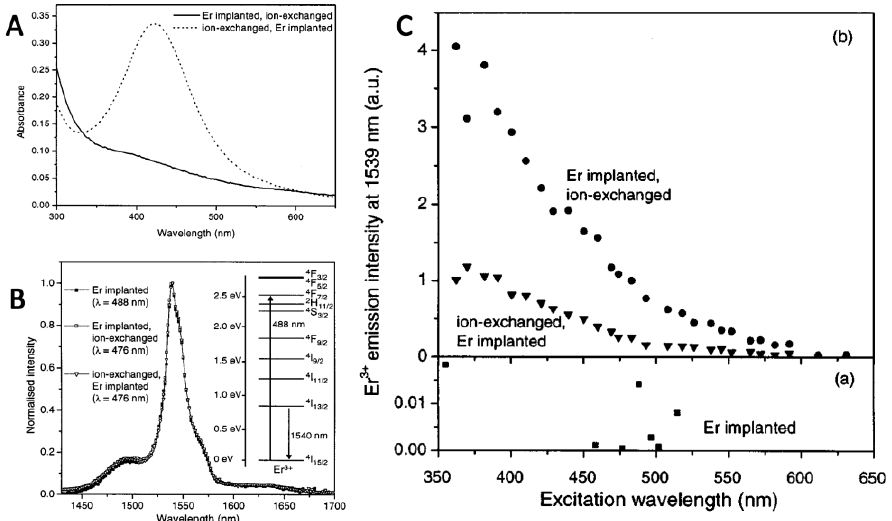
Figure 2. ( A ) Absorption spectrum of erbium-doped silver sample (ion-exchanged, Er implanted) and the reference is untreated glass (Er implanted, ion-exchanged). ( B ) Emission spectra of Er 3+ material doped with Ag; the inset is image of the energy level scheme of Er 3+ . ( C ) Relationship between photoluminescence intensity and excitation wavelength of three different samples at 1539 nm: ( a ) Erbium-doped borosilicate glass ( b ). Erbium- and silver-doped borosilicate glass. Reference [41].